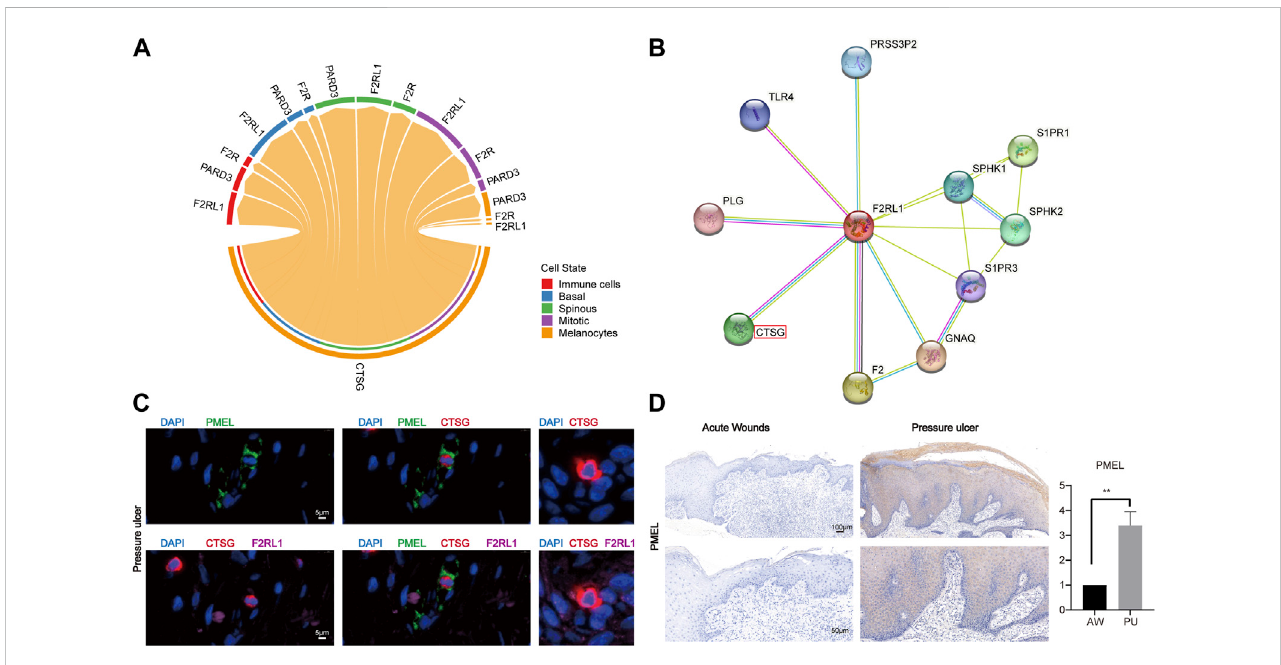
FIGURE 6 Melanocytes may lead to chronic in fl ammation in pressure ulcers through CTSG. (A) , The cell-cell communications of melanocytes population with other cell populations via ligand-receptor pairs of PARs pathway in PU. (B) , STRING interaction network of CTSG and F2RL1 protein. (C) , the immuno fl uorescence results of PMEL, CTSG, and F2RL1 in PU tissue (n = 4, Scale: 5 μ m). (D) , the immunohistochemical staining results of PMEL in AW (n = 4) and PU (n = 5) tissue. Data represent the mean ± S.D. ** p < 0.01 (Scale bar: 100, 50 μ m). AW: acute wounds; PU: pressure